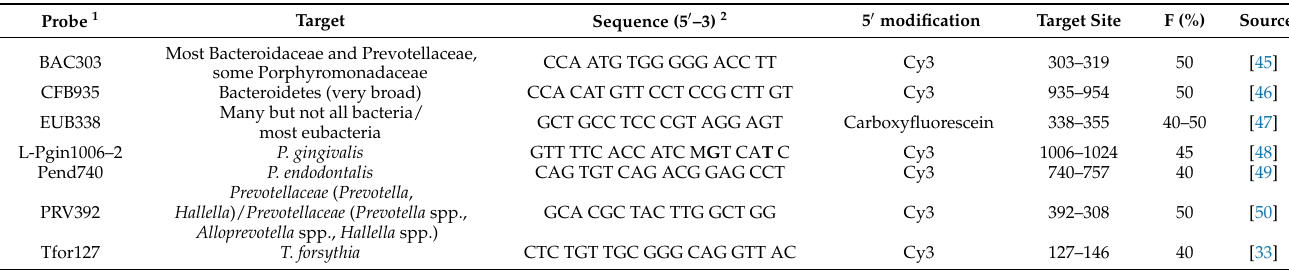
Table 1. Characteristics of 16S rRNA-directed oligonucleotide probes used for FISH; target organisms, rRNA sequences, target site, and formamide concentration